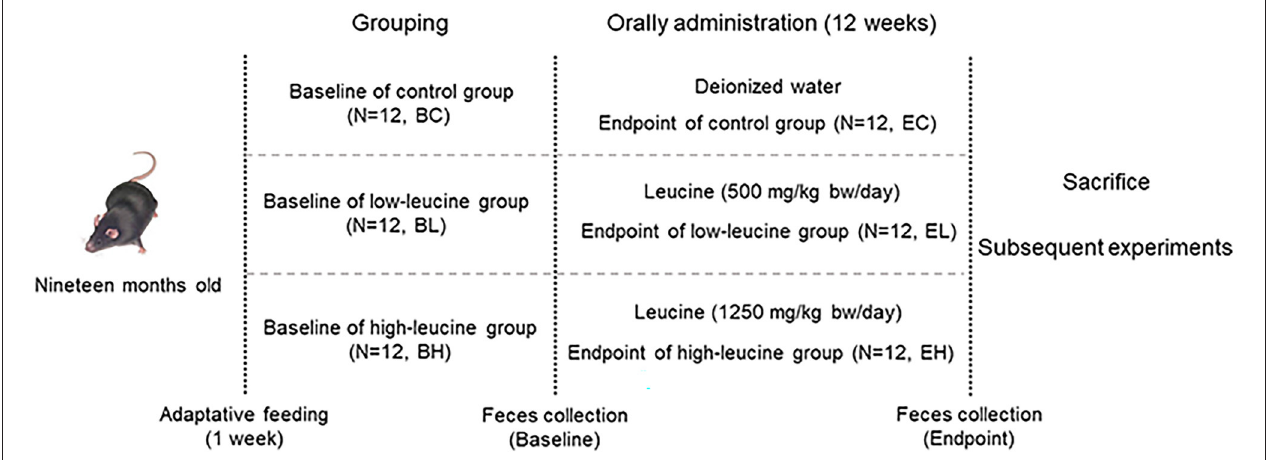
FIGURE 1 | Experiment design